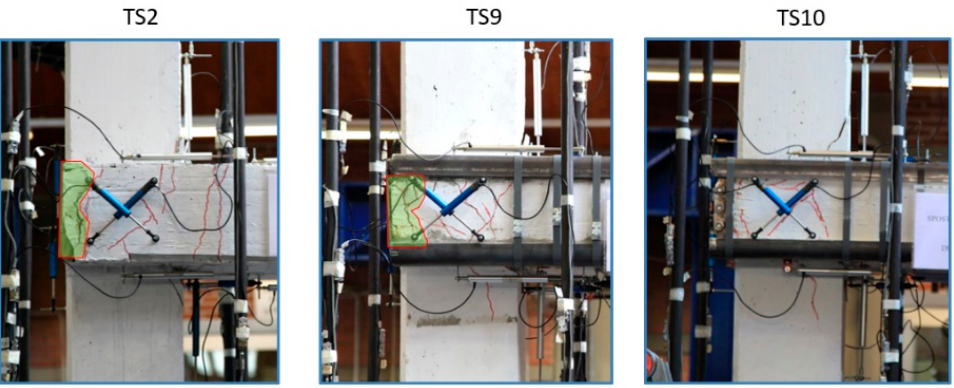
Figure 9. Damage patterns visible at 3.0% drift. Green hatches represent spalled or nearly spalled regions.